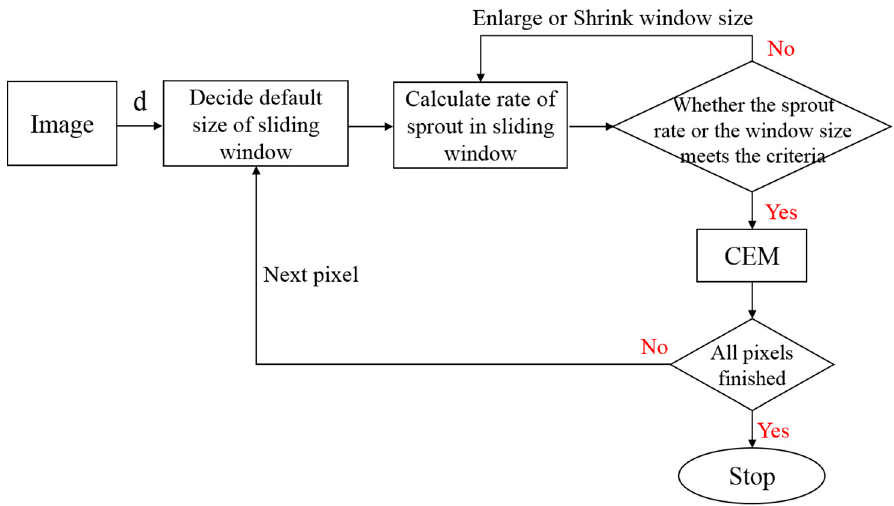
Figure 5. Flowchart of Adaptive Sliding Window-based CEM.